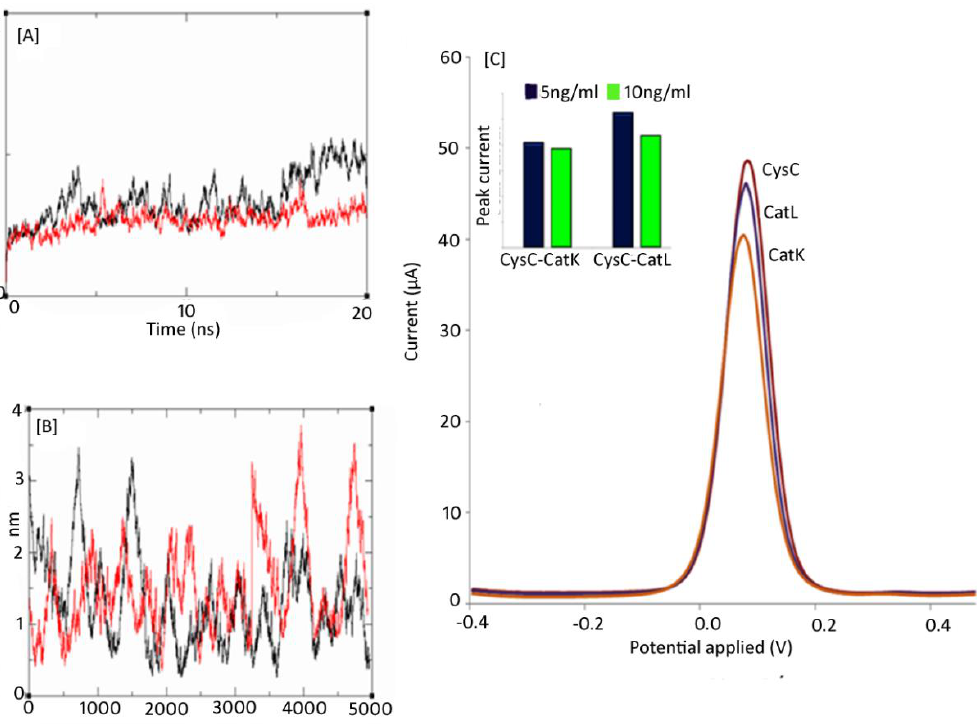
Figure 4. [A] . Protein RMSD is represented as a function of simulation time in black [CatL] and red [CatK] respectively. [B] . The per residue RMSF has been represented as a function of the residue number in black [CatL] and red [CatK], respectively, [C] . The DPV graphs of CysC in the presence of CatL and CatK on the multiwalled carbon nanotube based electrode (inset) Effect of changing concentration of CatL and CatK on peak current